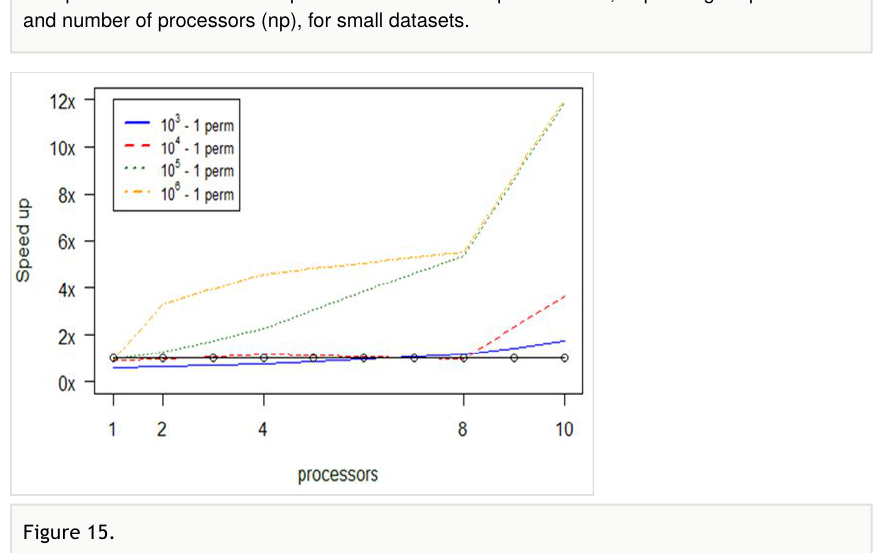
and number of processors (np), for large